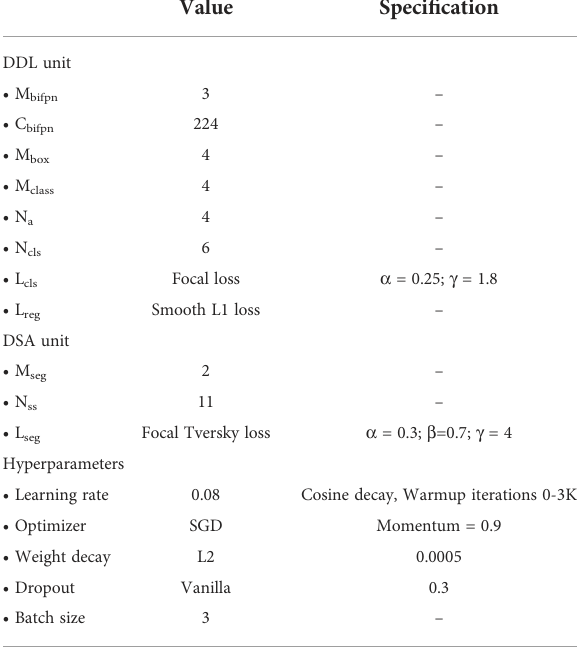
TABLE 3 Speci fi cations and hyperparameter settings for the DIANA framework.